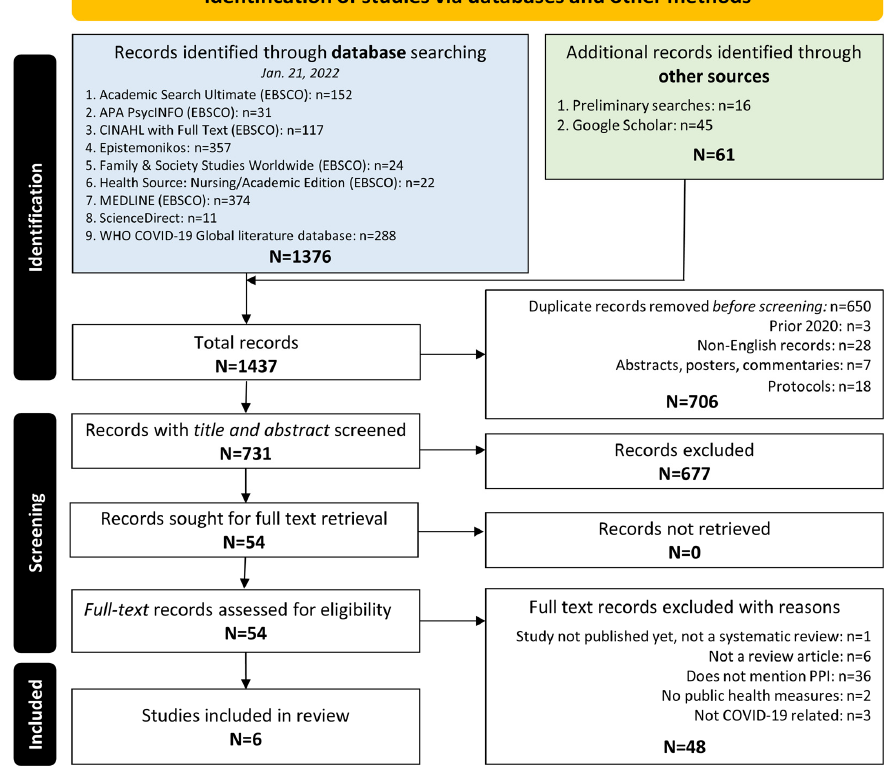
Figure 1. PRISMA flow diagram.